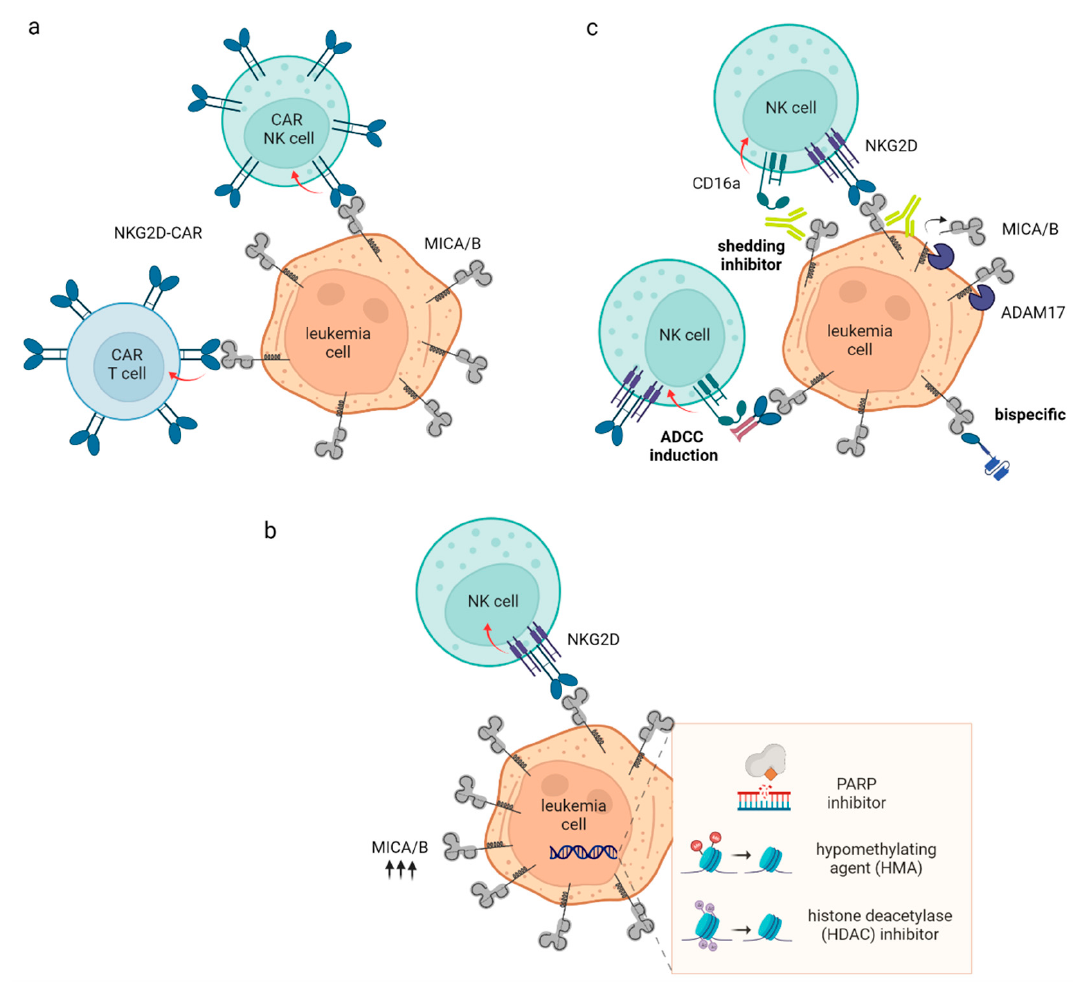
Figure 1. Modalities of NKG2DL-based immunotherapy in AML. ( a ) Cellular therapies consisting of NK or T cells expressing the NKG2D ectodomain fused to cytoplasmic signaling domain(s). NKG2D-CAR recognize the whole NKG2D ligandome and induces potent T and NK cell antitumor reactivity, respectively. ( b ) Epigenetic compounds such as PARP/histone deacetylase (HDAC) inhibitors or hypomethylating agents (HMA) lead to substantial upregulation of surface NKG2DL expression and thus re-sensitize AML cells to NKG2D-mediated NK/T cell immunity or make them susceptible to NKG2DL-based targeted therapies. ( c ) Antibodies (Ab) and engineered antibody-like formats which bind to NKG2DL and engage CD16a on NK cells. An Ab which binds to the α -3 domain of MICA/B and thereby blocks their shedding from the tumor surface is currently evaluated in a clinical trial. Additionally, Fc-optimized NKG2D-Ig fusion proteins have been tested to induce ADCC against target cells which express any of the 8 NKG2DL and enhanced the anti-leukemic reactivity of NK cells. Similarly, an NKG2DxCD16a bispecific has been tested which consists of the NKG2D ectodomain fused to an anti-CD16a single chain variable fragment (scFv) and consequently displays higher affinity to the Fc receptor than Fc domains. This figure was created with